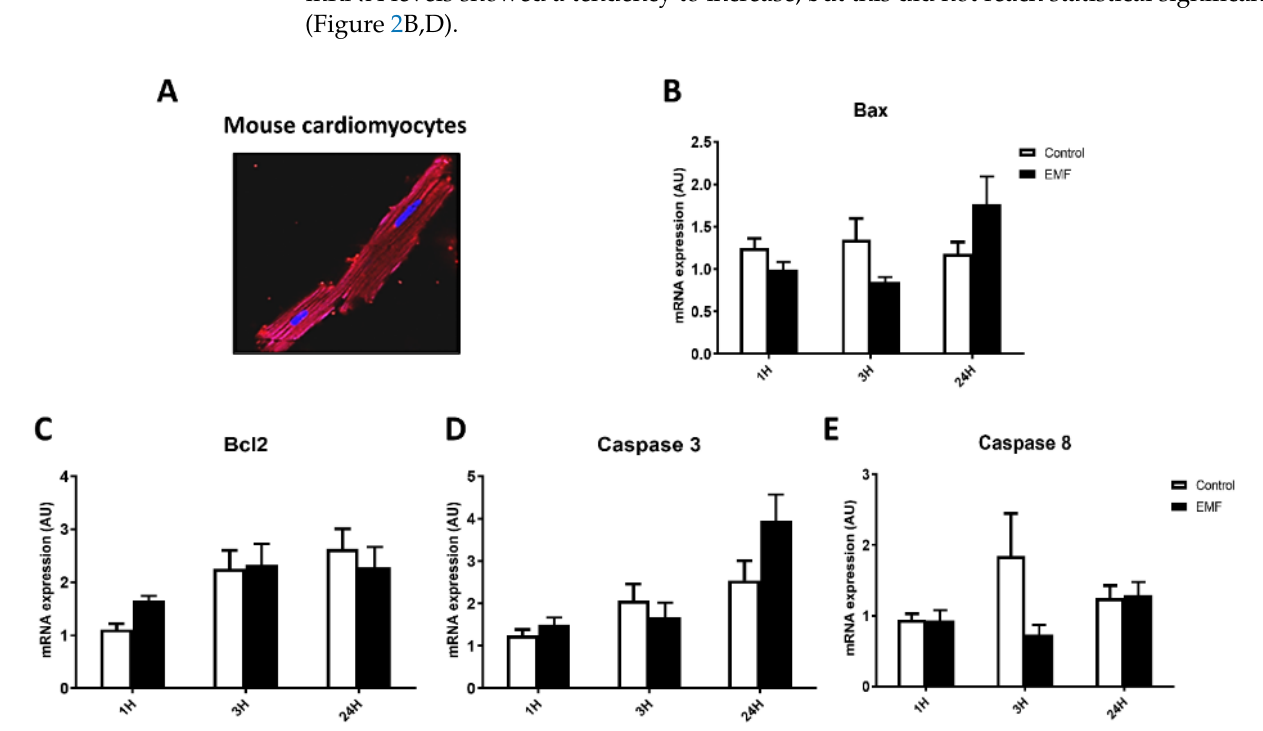
Figure 2. Apoptosis-related gene expression in mouse cardiomyocytes exposed to EMFs. Representative pictures of cultured mouse cardiomyocytes ( A ) and mRNA expression levels of Bax ( B ), Bcl2 ( C ), caspase 3 ( D ), and caspase 8 ( E ) in cardiomyocytes exposed to 915 MHz EMFs for 1 h, 3 h, and 24 h. The results present the mean ± SEM of three independent experiments.